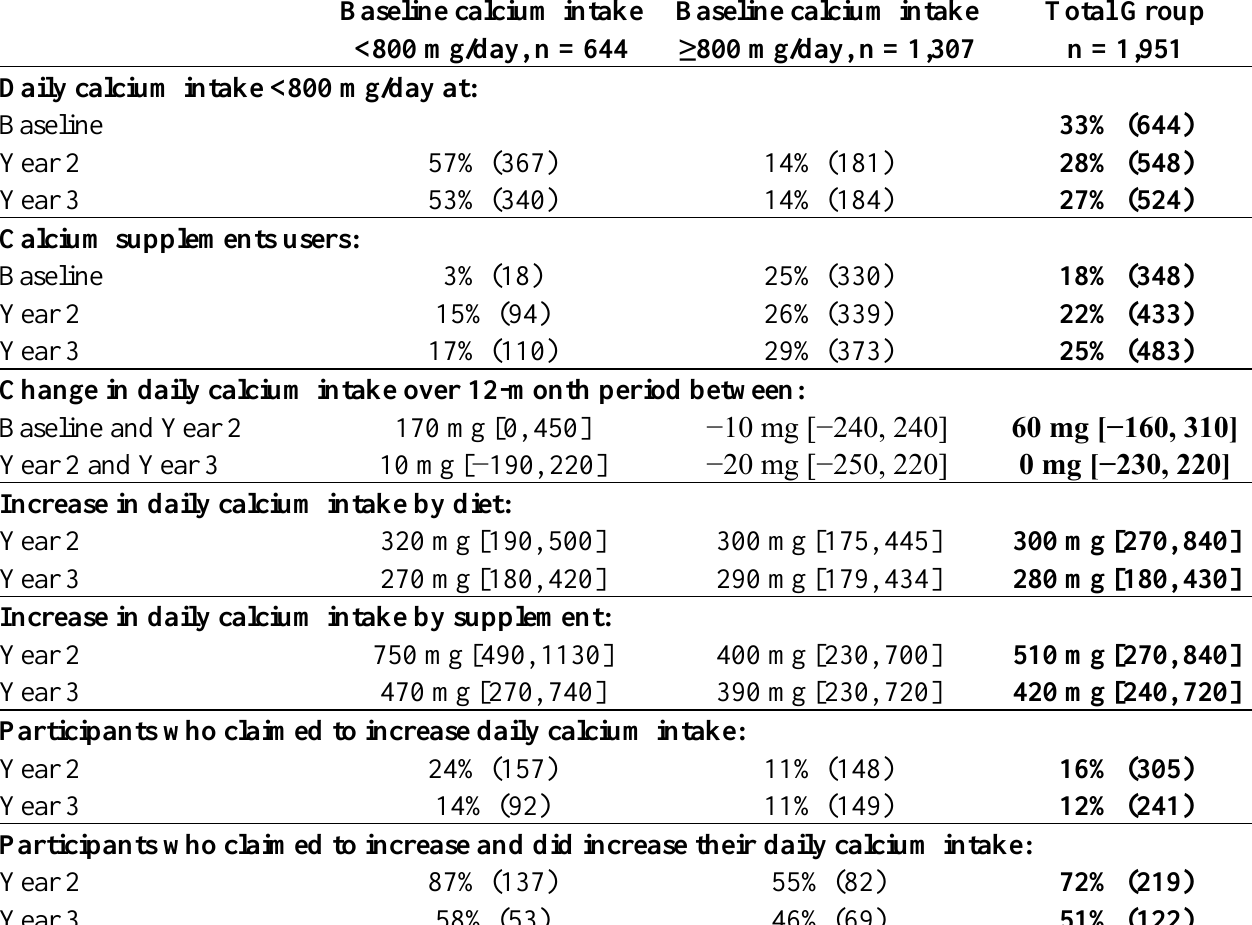
Table 2. Change in dietary calcium intake in those above and below 800mg intake/day at